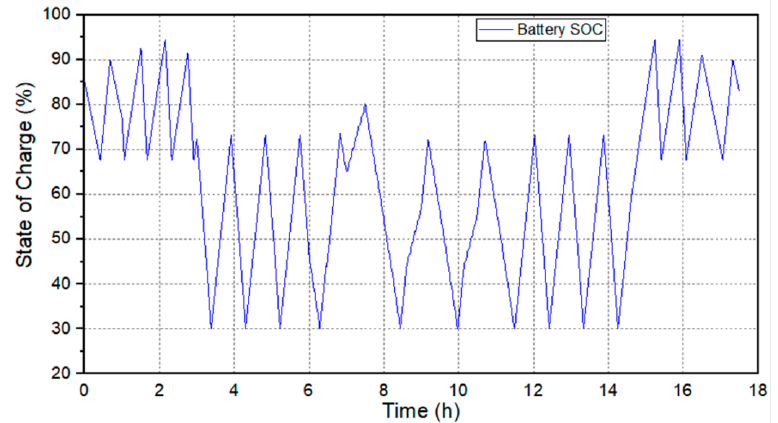
Figure 14. Variation of battery SOC during